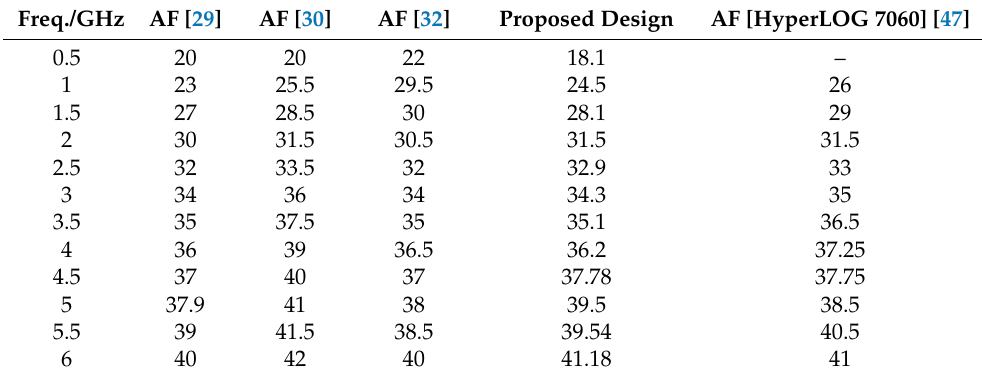
Table 6. Antenna factor comparison of the proposed design, the literature reviewed papers, and commercial design HyperLOG